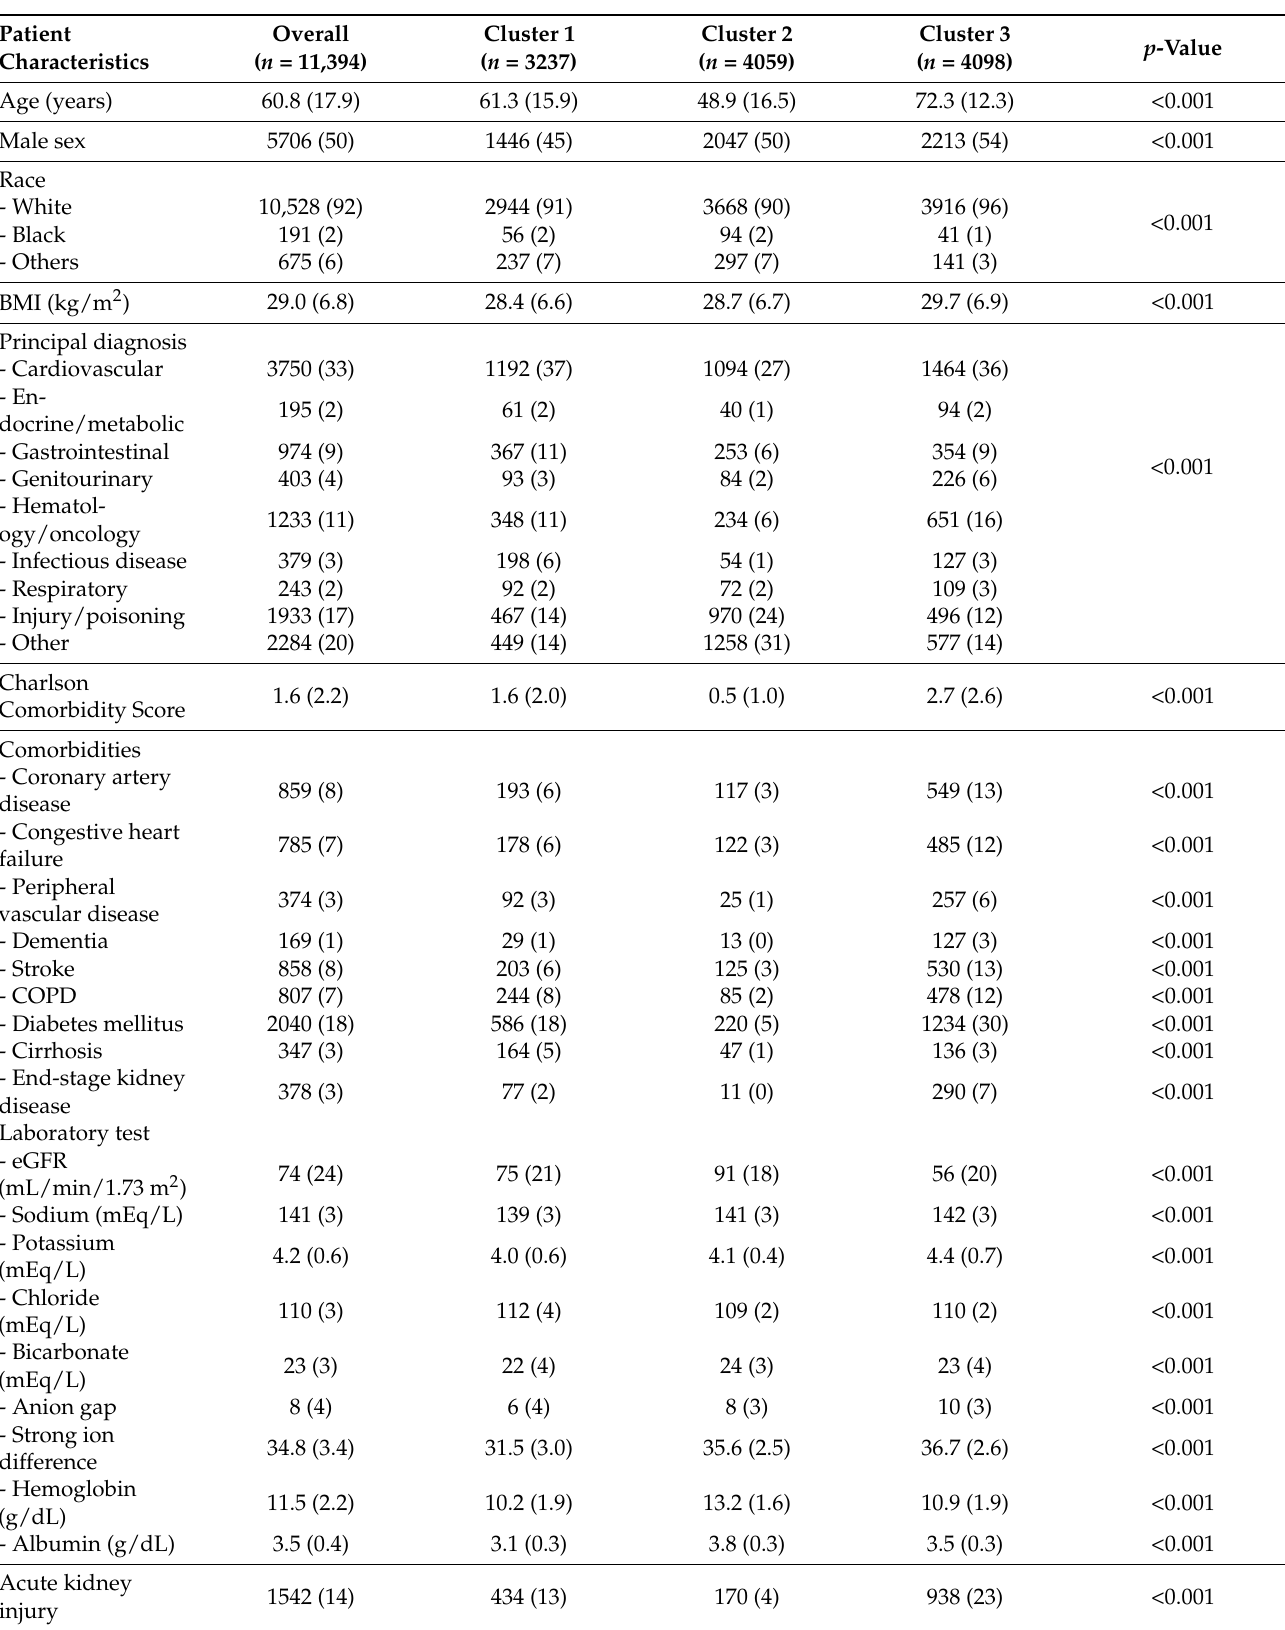
Table 1. Clinical characteristics according to the distinct clusters of hyperchloremia